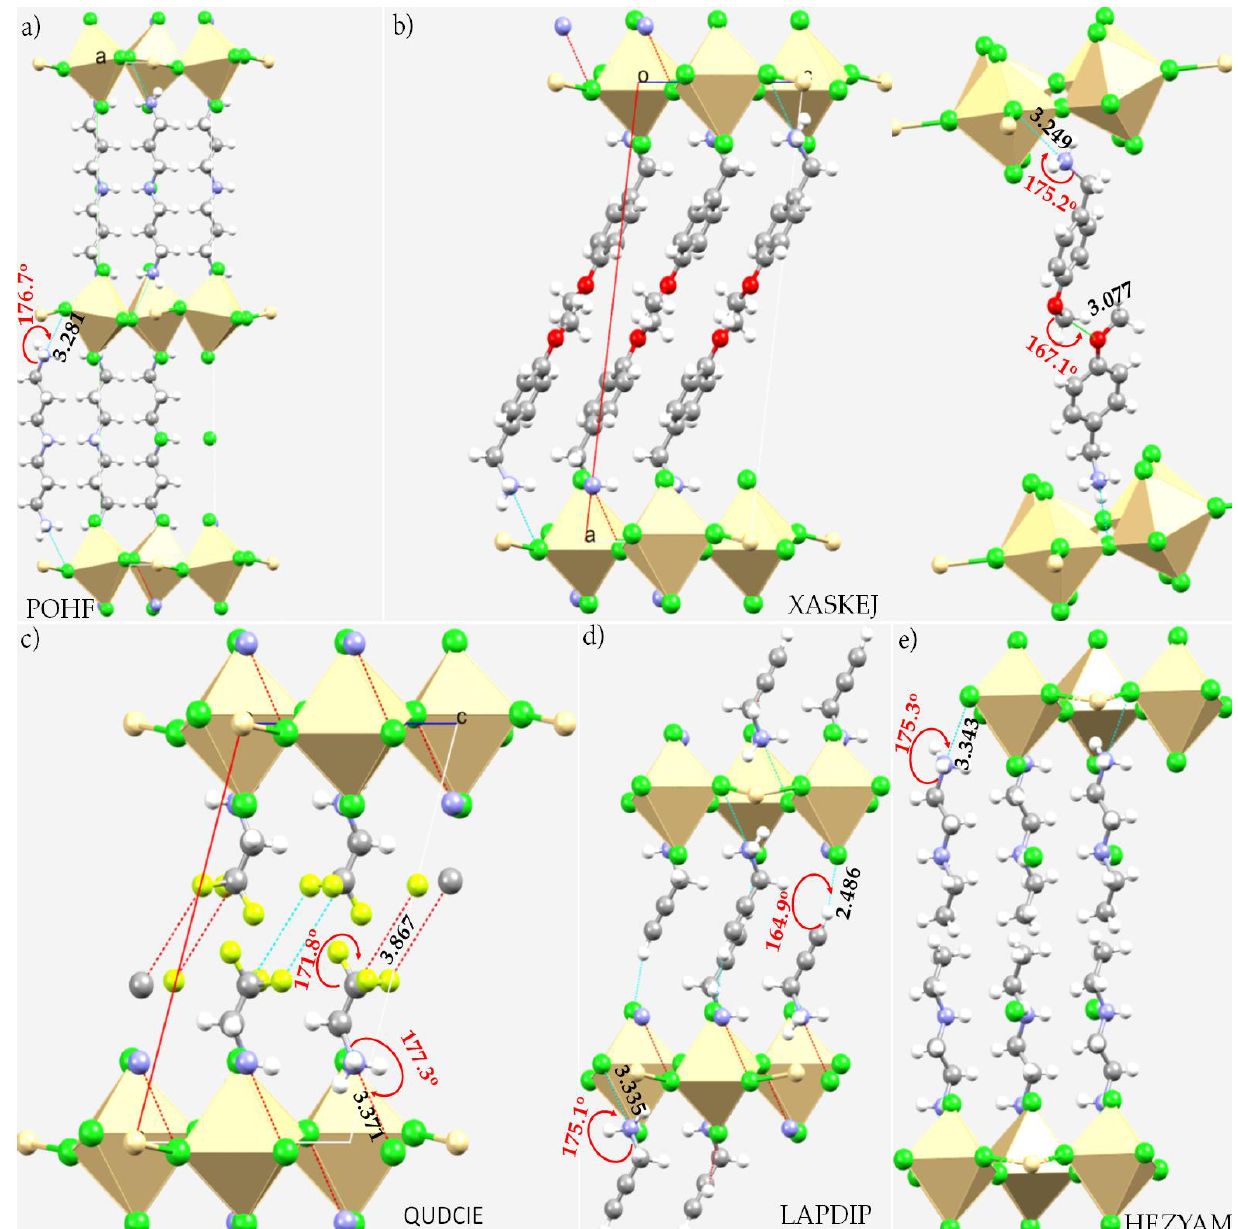
Figure 16. Polyhedral and ball-and-stick representations of ( a ) ( C 6 H 20 N 3 ) 2 [Cd 2 Cl 10 ] (CSD ref. POHFEA [114]); ( b ) (OMeC 6 H 4 CH 2 NH 3 ) 2n · n (CdCl 4 ) (CSD ref. XASKEJ [115]); ( c ) 2[CH 2 FCH 2 NH 3 ]·[CdCl 4 ] (CSD ref. QUDCIE [116]); ( d ) (CHCCH 2 NH 3 ) 2 n · n (CdCl 4 ) (CSD ref. LAPDIP [117]; and ( e ) (CH 3 CH 2 NH 2 CH 2 CH 2 NH 3 ) 2 n · n (CdCl 4 ),2 n Cl (CSD ref. HEZYAM [118]). Intermolecular interactions are marked as dotted lines in cyan, the hanging contacts are marked as dotted lines in red. Selected bond distances and bond angles are in Å and degrees, respectively.